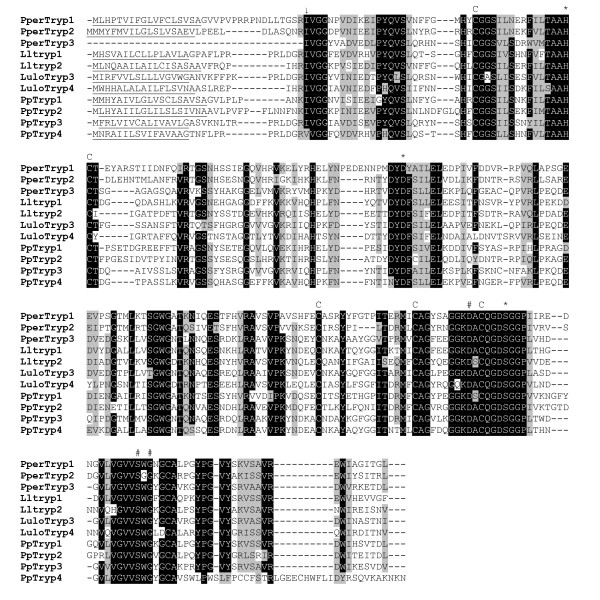
Multiple sequence alignment of putative sand fly trypsins. Pper: Phlebotomus perniciosus, Pp: Phlebotomus papatasi, Lulo: Lutzomyia longipalpis. Predicted signal peptides are underlined, the putative activation cleavage site is indicated by (↓), conserved cysteines (C), catalytic H/D/S residues marked by (*) and substrate binding site marked by (#). Accession numbers: PperTryp1 [GenBank:EZ933288], PperTryp2 [GenBank:EZ933289], PperTryp3 [GenBank:EZ933290], Lltryp1 [GenBank:ABM26904], Lltryp2 [GenBank:ABM26905], LuloTryp3 [GenBank:ABV60308], LuloTryp4 [GenBank: ABV60300], PpTryp1 [GenBank:AAM96940], PpTryp2 [GenBank:AAM96941], PpTryp3 [GenBank:AAM96942], PpTryp4 [GenBank:AAM96943].